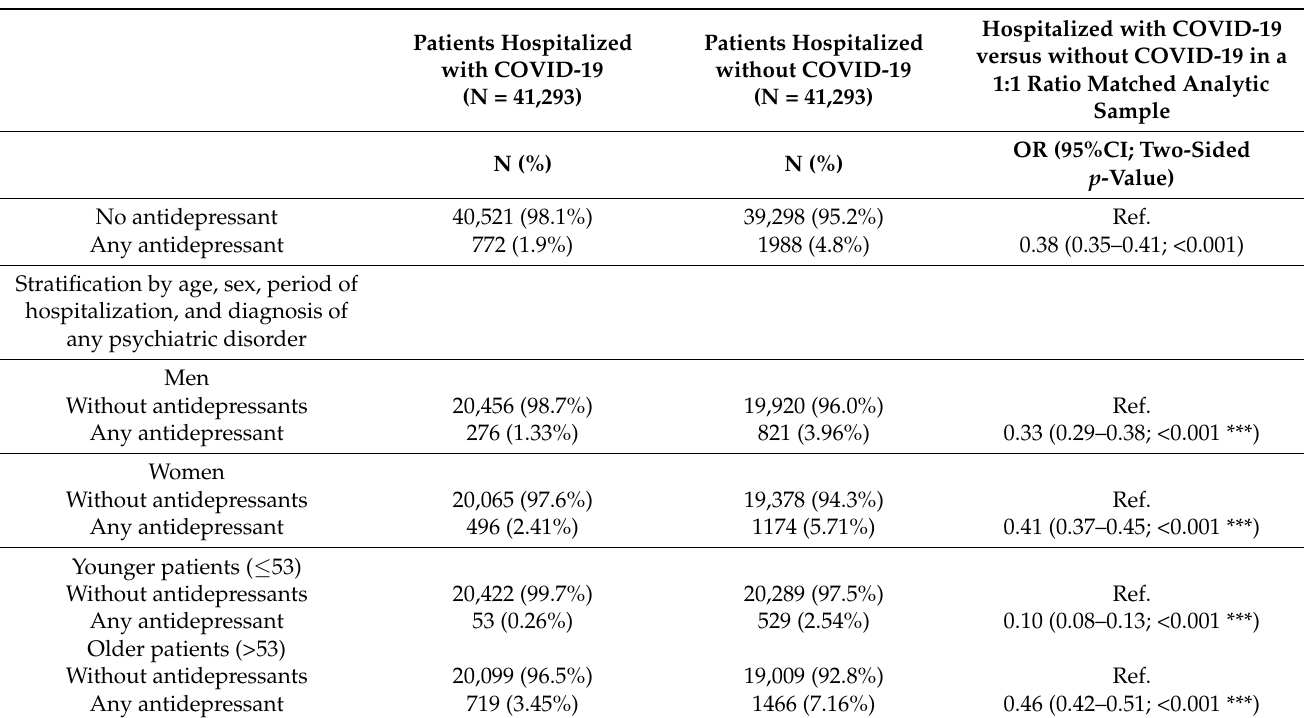
Table 1. Prevalence of antidepressant use in a matched analytic sample of adult patients hospitalized with and without COVID-19 (N =